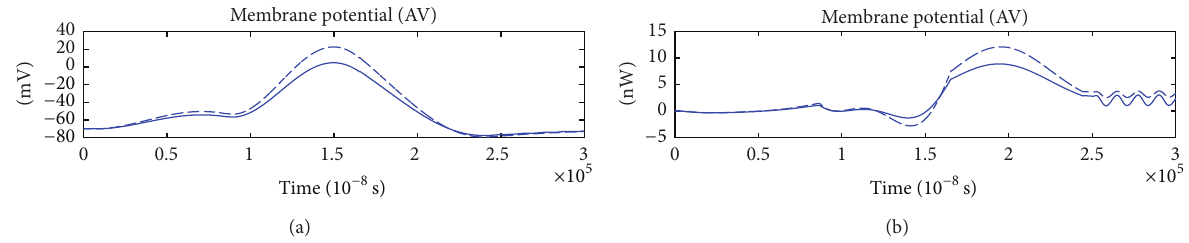
Figure 8: The action potential and its corresponding energy function. 𝑟 0𝑚 = 0.0001 Ω , 𝑟 1𝑚 = 0.1Ω , 𝑟 2𝑚 = 1000 Ω , 𝑟 3𝑚 = 0.1 Ω , 𝑟 𝑚 = 1000 Ω , = 1 𝜇 F, 𝐿 = 50 𝜇 H, 𝑖 = 70.7 𝜇 A, and 𝑄 = 6 × 10 −6 𝜇 A. 𝐶 𝑚 𝑚 0𝑚